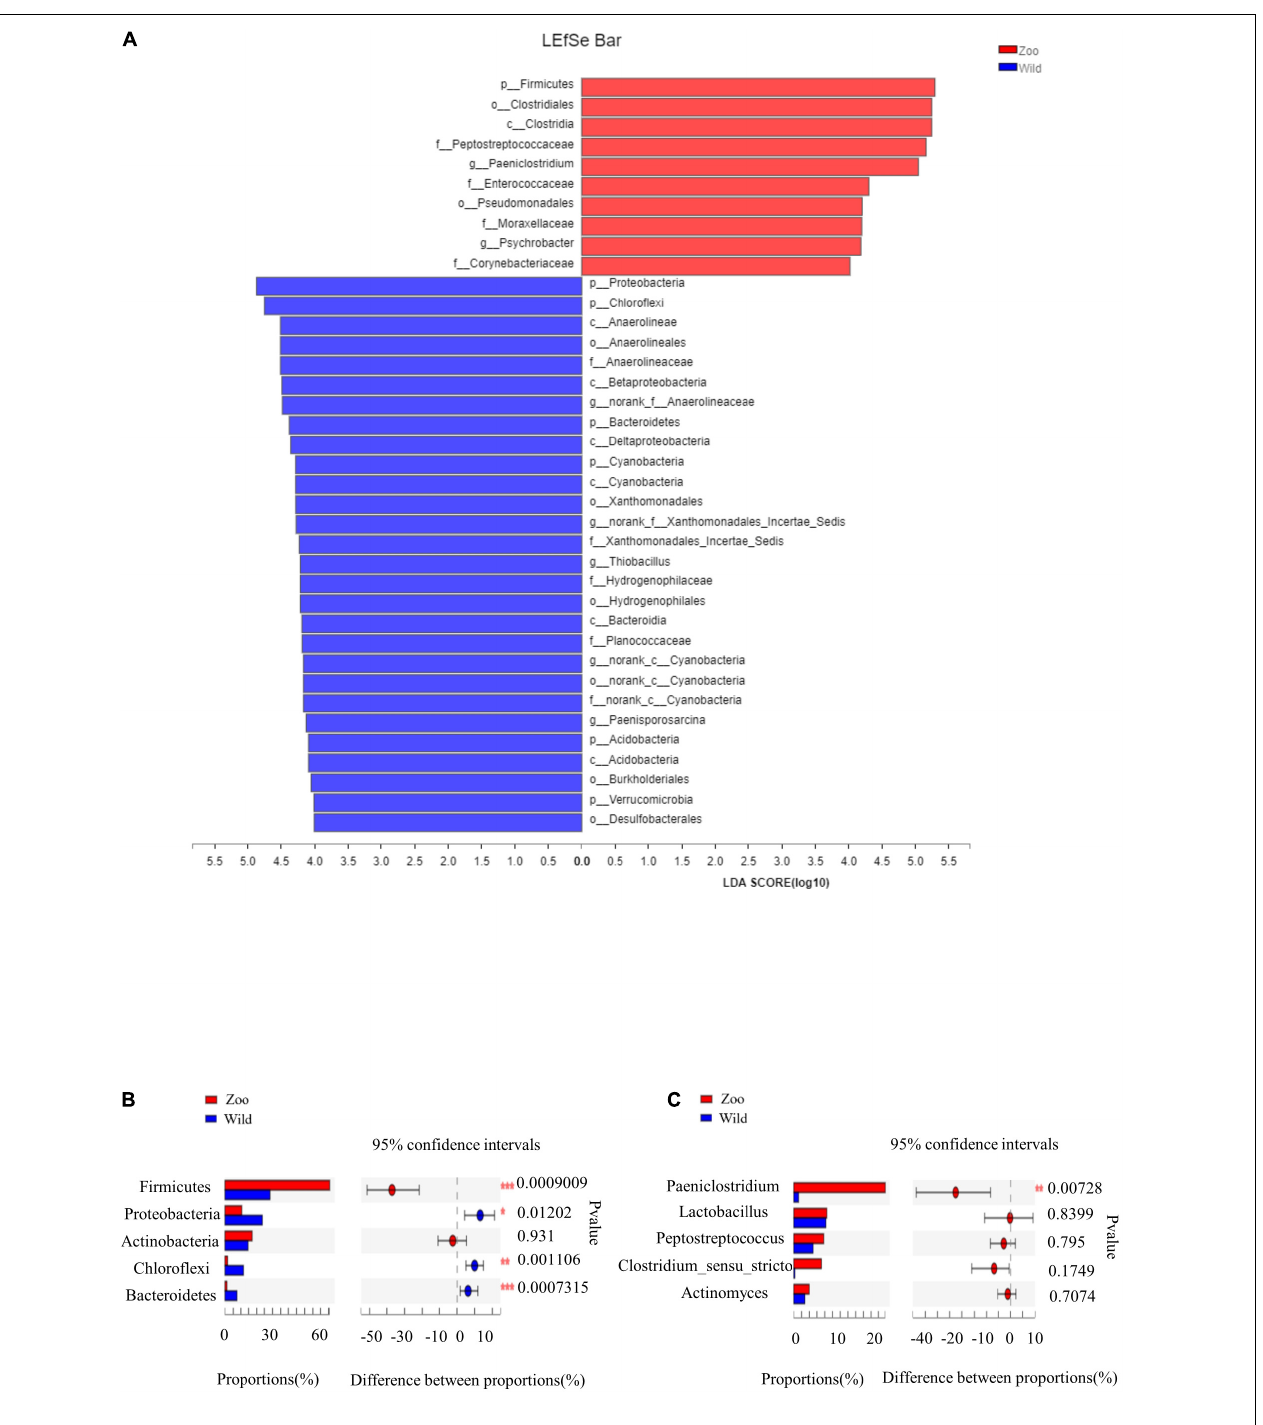
FIGURE 4 | LEfSe analysis of gut microbiota and comparison of core gut microbiotas. (A) LEfSe analysis based on characterizing discriminative features of OTUs. (B) Top five abundant core phyla in two groups of oriental white storks. (C) Top five abundant core genera in two groups of oriental white storks.